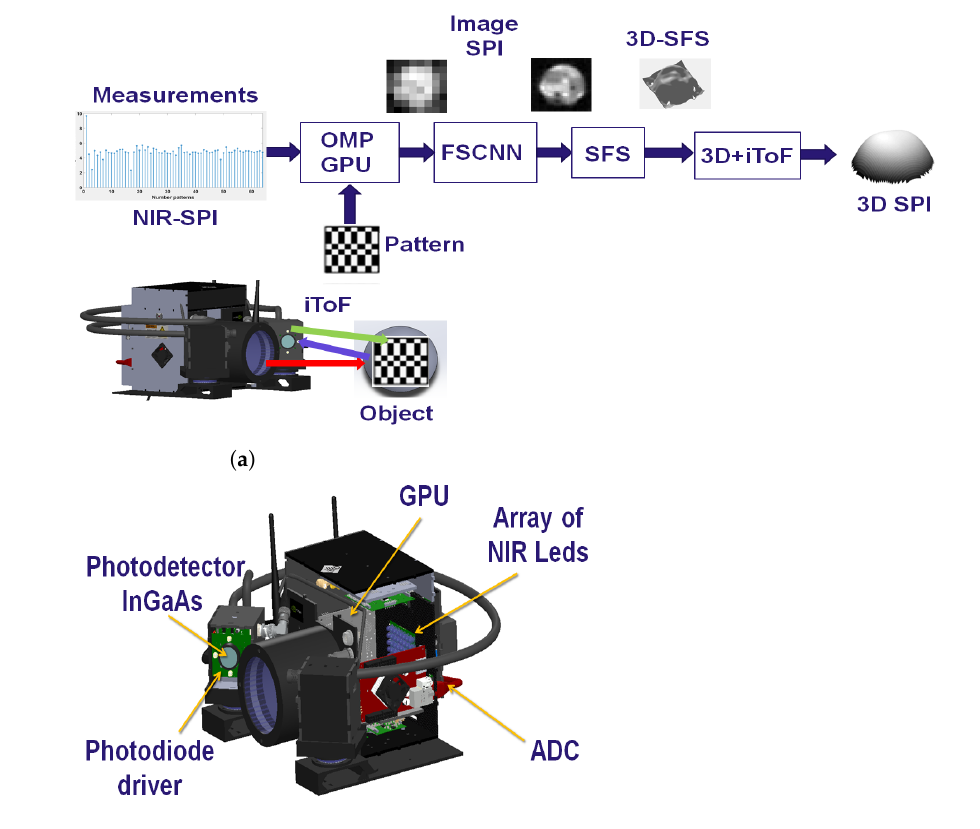
Figure 3. Proposed 2D/3D NIR-SPI camera system: ( a ) the sequence used for projection of active illumination patterns and reconstruction of 2D/3D images using the SPI approach; ( b ) The NIR-SPI system proposed and its subsystems: dimension is of 11 × 12 × 13 cm, weight 1.3 kg, and power consumption of 25 W module photodiode InGaAs, active illumination source, photodetector diode InGaAs FGA015, graphics processing unit (GPU) and Analog to Digital Converters